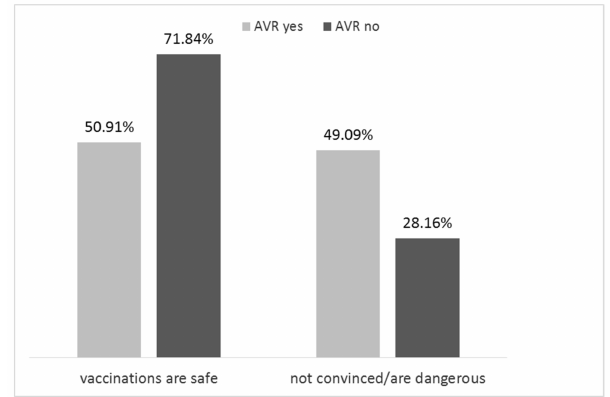
Figure 1. Percentage of parents’ responses to a questionnaire regarding the safety of vaccination in relation to ever occurred adverse vaccine reaction (AVR) in any